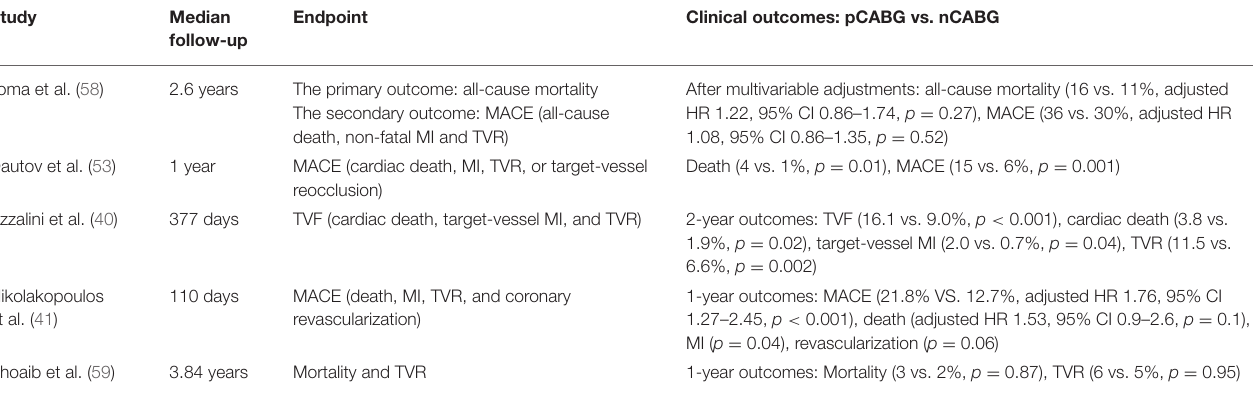
TABLE 2 | Major studies comparing long-term outcomes of pCABG vs. nCABG. Study Clinical outcomes: pCABG vs.